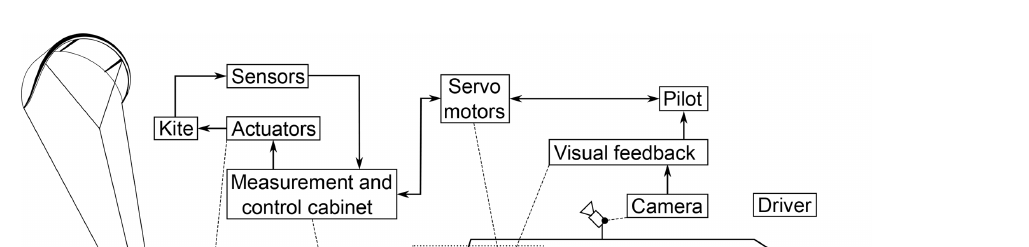
Figure 5. Components of the trailer-mounted test bench.